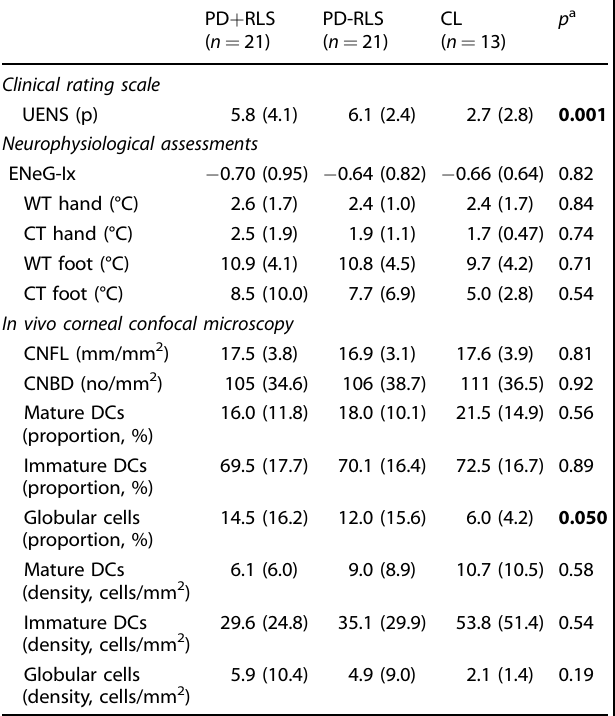
Table 2. Neurophysiological, corneal, and clinical assessments of peripheral neuropathy.